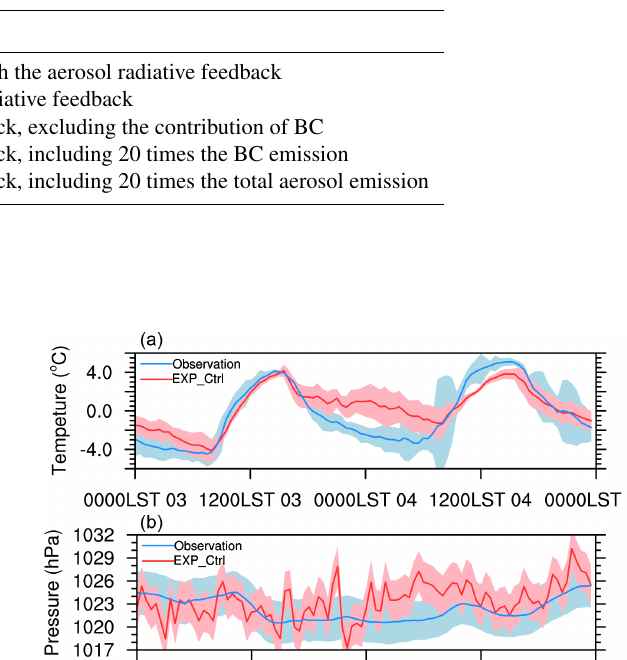
Table 2. Descriptions of five parallel WRF-Chem numerical experiments.